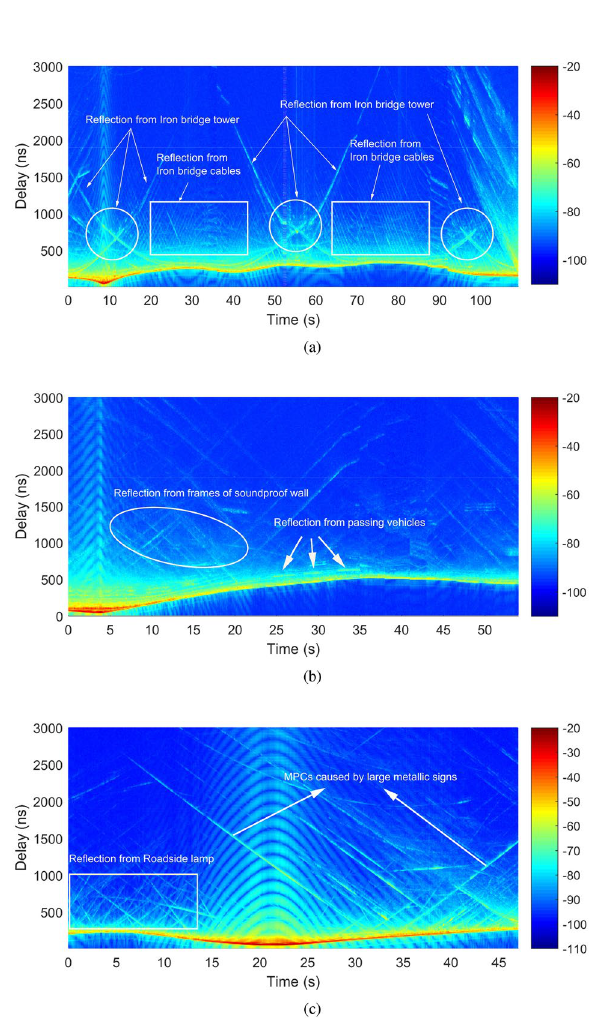
Figure 3. Power delay profiles of the measured scenarios. ( a ) Iron bridge. ( b ) Soundproof wall. ( c ) Roadside